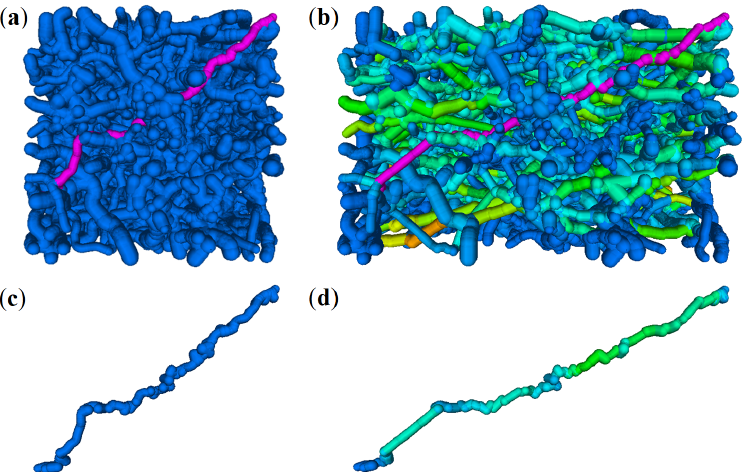
Figure 14. Visualization of a single fiber-bundle from L1, back with volume fraction 61%. ( a , c ): simulation start, ( b , d ): pulled state. ( a , b ): complete mesh with a marked thread; ( c , d ): the marked thread,